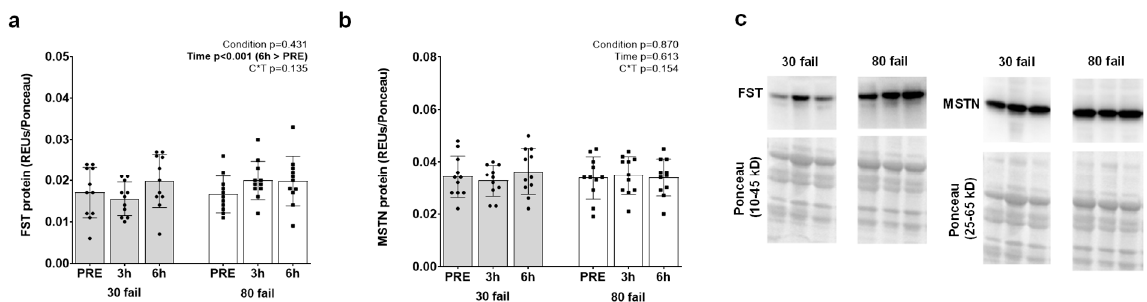
Figure 5. FST and MSTN protein responses. The effects of each bout on the protein expression of follistatin (FST) (Panel ( a )) and myostatin (MSTN) (Panel ( b )) are presented. Resistance exercise (re-gardless of load) increased FST levels 6 h following exercise. Panel ( c ) contains representative blots of the assayed targets; note these targets came from the same participant, which is why the Ponceau stains are similar.